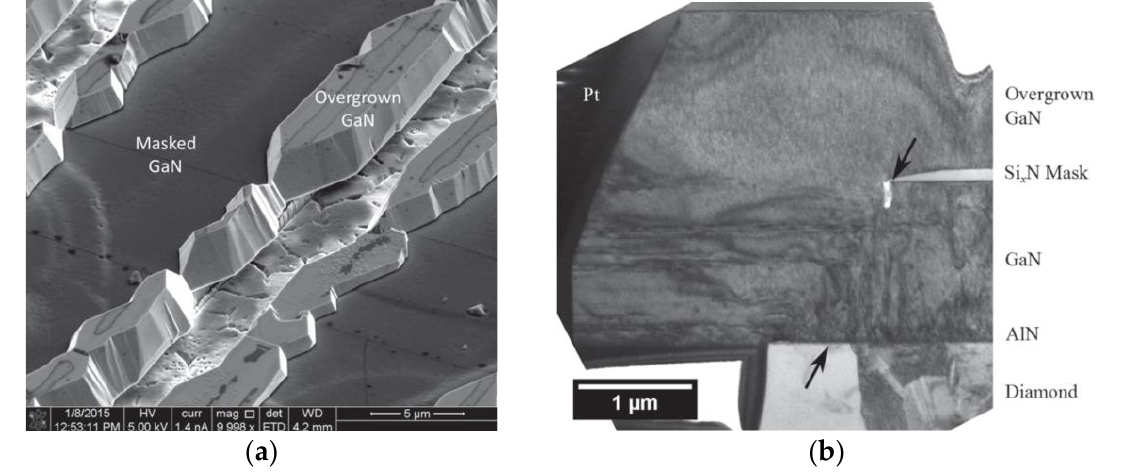
Figure 11. ( a ) SEM image of masked and ELO growth of GaN. ( b ) TEM image showing original and ELO growth of GaN; arrows indicate boundary between original (right of boundary) and ELO (left of boundary) growth (reprinted from [124]; permission conveyed through CCBY 3.0).